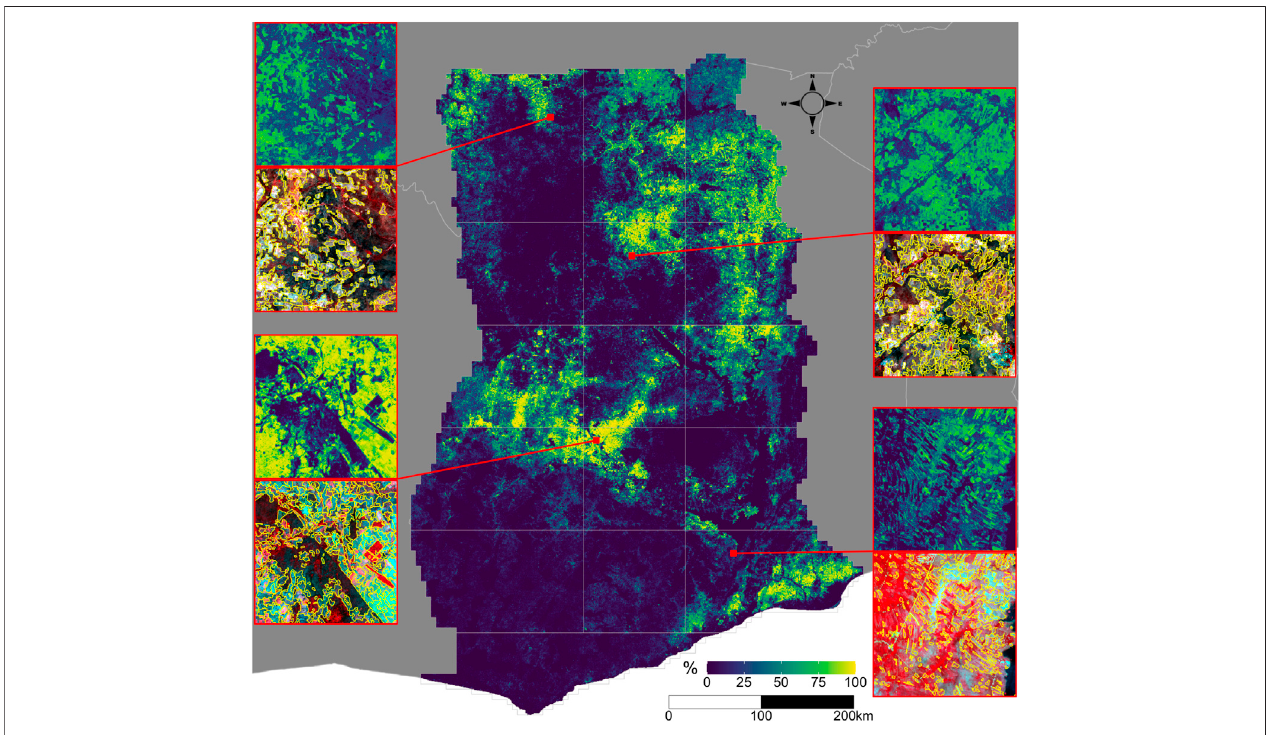
FIGURE6| Thedistribution ofcroplandsinGhana. Themainmapshowsthepercentage ofcroplands ineach 0.005 ° gridcell,derivedfrom thepredictedcropland probabilities. The insets on the margins illustrate predicted probabilities (top map in each couplet) at original image resolution (0.000025 ° ) and segmented fi eld boundaries overlaid on the dry season PlanetScope composite, for four separate tiles. Each tile ’ s position is shown on the main map by the red line.